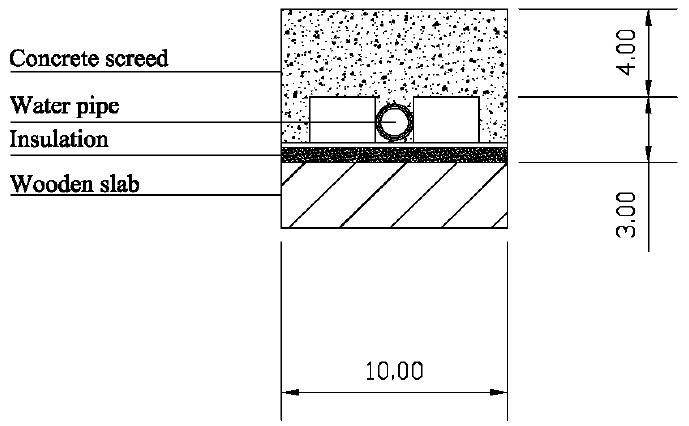
Figure 3. Vertical section of the room multilayer floor (thicknesses expressed in cm).